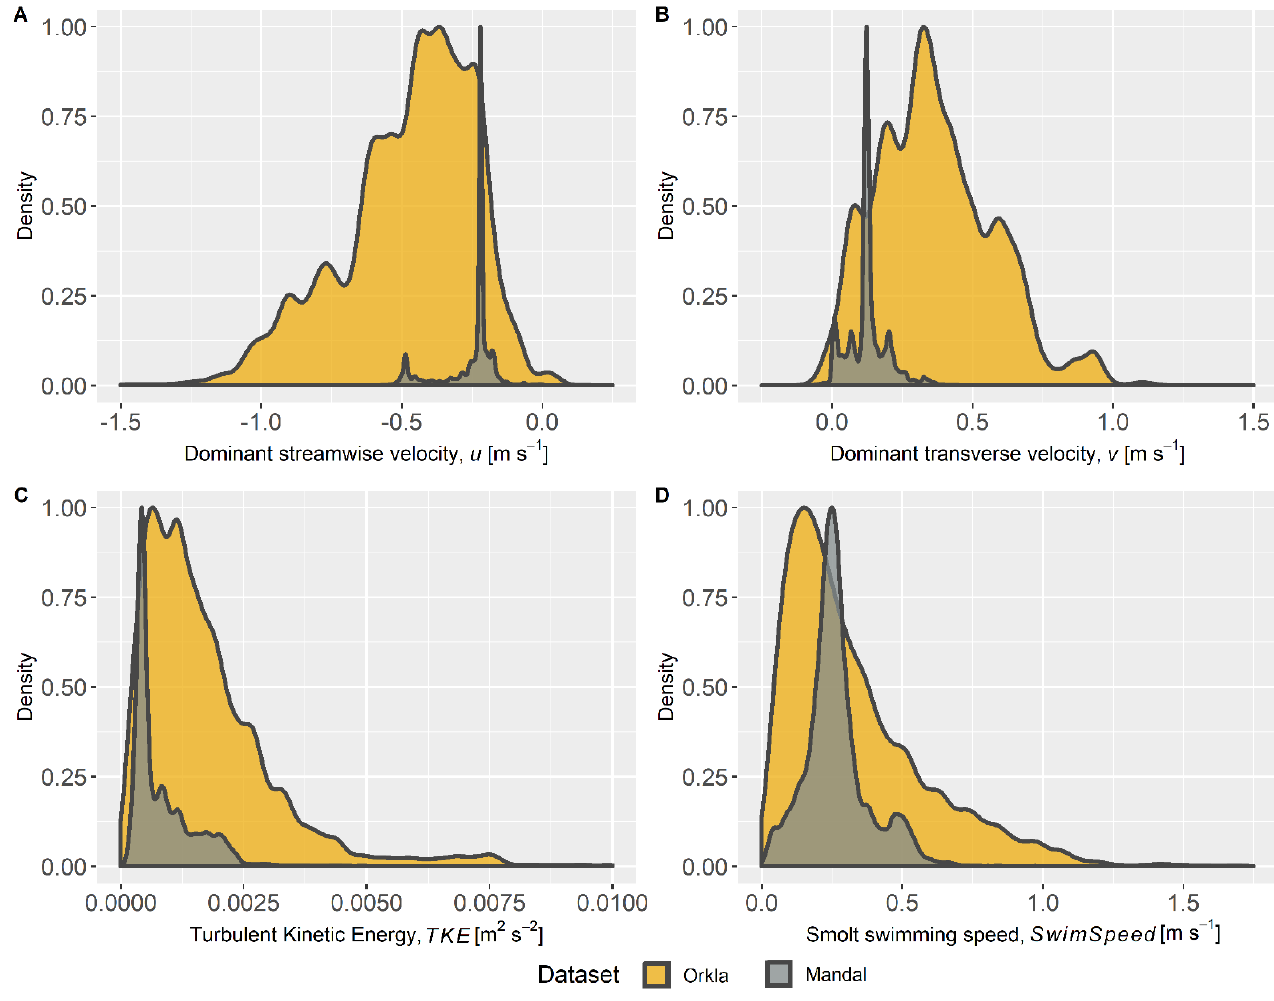
Figure 2. Distributions of the linked hydraulic variables and the swimming speed of smolts at the River Orkla (yellow) and River Mandalselva (grey) sites, which were used for model testing. The variables are presented in the following order: top row: streamwise velocity— u ( A ), transverse velocity— v ( B ); bottom-row: turbulent kinetic energy— TKE ( C ), Smolt swimming speed— SwimSpeed ( D ).